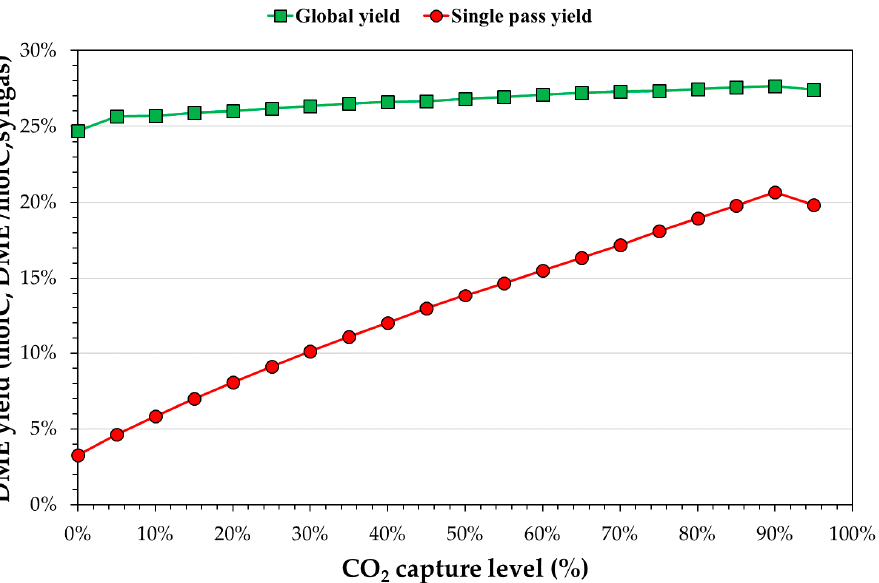
Figure 9. Theoretical equilibrium DME yield (global or single-pass) with respect to the CO 2 capture, fixing the WGS conversion and the purge ratio to 0% and 10%, respectively.